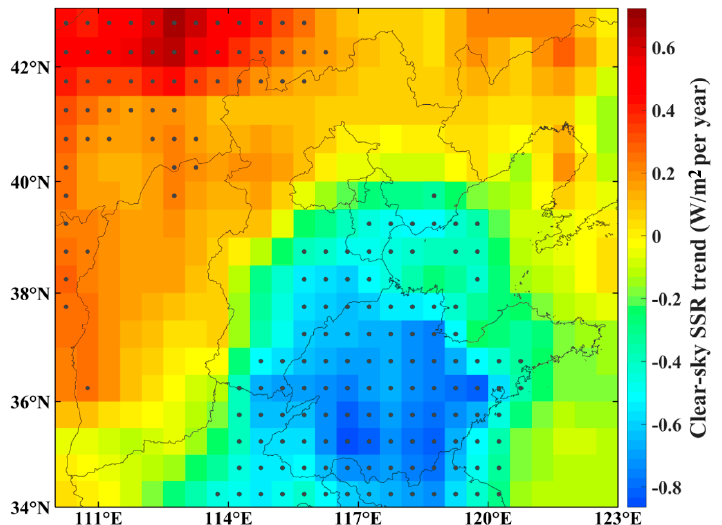
Figure 12. Spatial distribution of deseasonalized trends of clear-sky SSR in northern China during 2001–2015. Regions with significant trends (p value < 0.05) are indicated by dots.